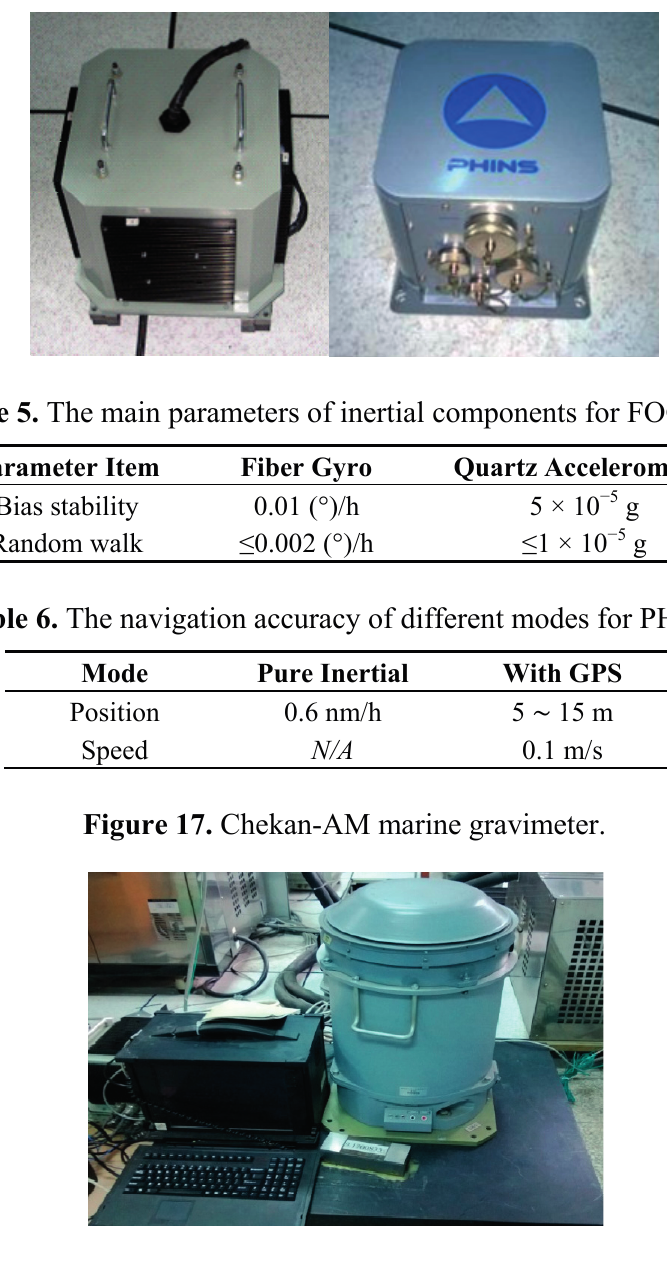
Figure 16. FOG-INS and PHINS.